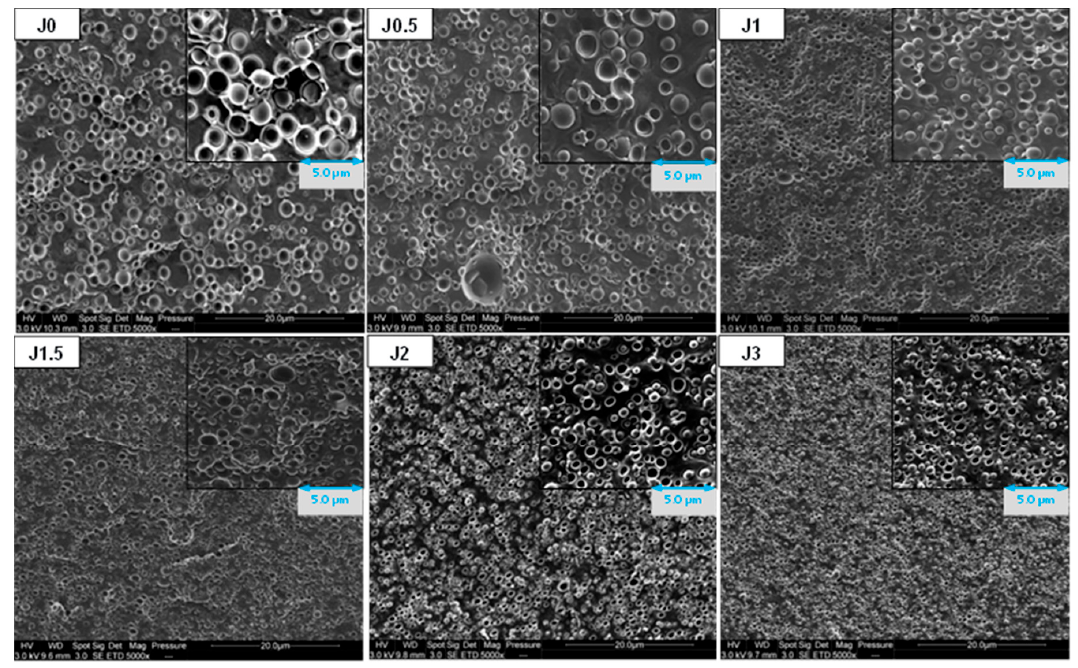
Figure 2. SEM observations of extruded samples threads in transversal direction.